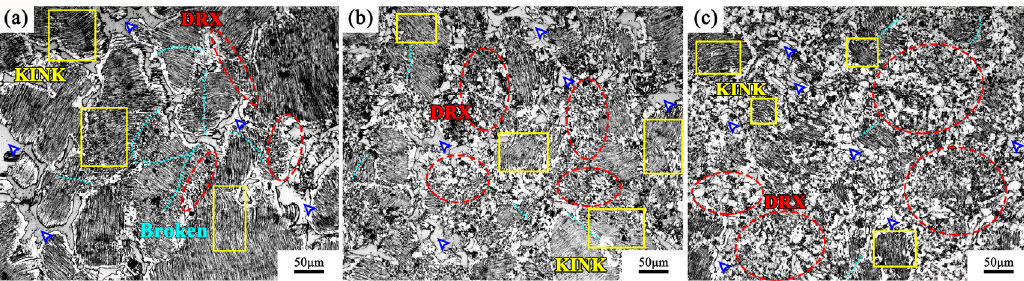
Figure 3. Optical microscope (OM) images of the alloys under di ff erent multi-directional forging (MDF)ed passes: ( a ) 1 pass; ( b ) 2 passes; ( c ) 3